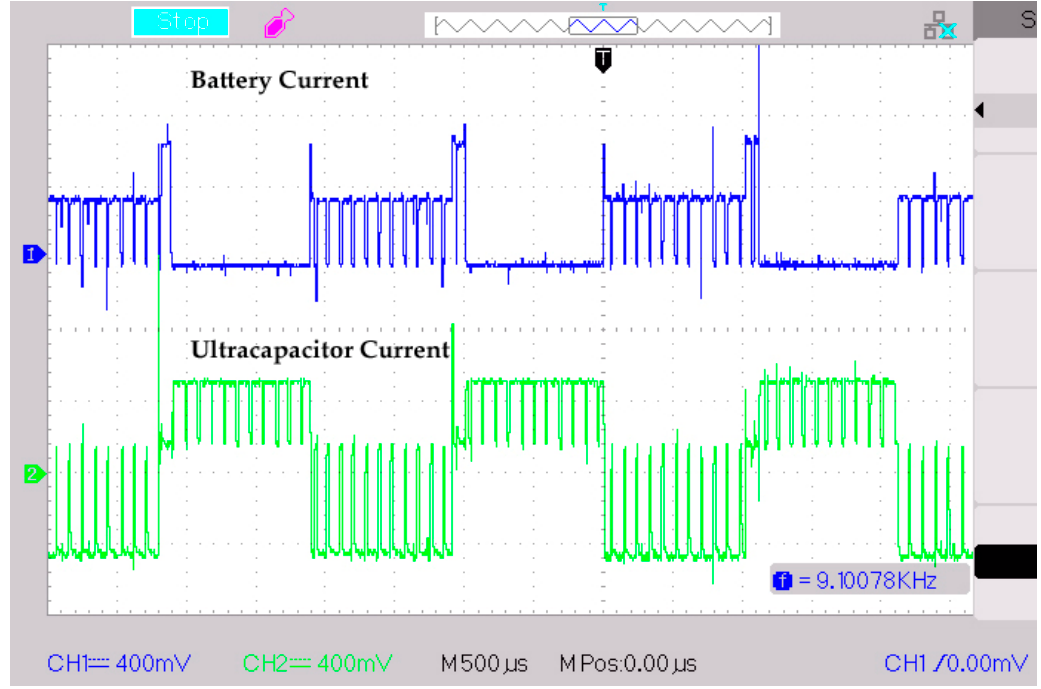
Figure 36. Battery and ultra-capacitor currentsmode-2 and mode-3 with t 1 = 0.5 ms t 2 = 0.5 ms. Case-3: In this case (Figure 37) the load is fulfilled through individual ultracapacitor, battery and ultracapacitor together, and individual battery for 0.5ms each. For mode-3, the battery current is 0.04 A, for mode-2 it is 1.6 A and for mode-1 it is 2.8 A. The average battery current is 1.48 A.